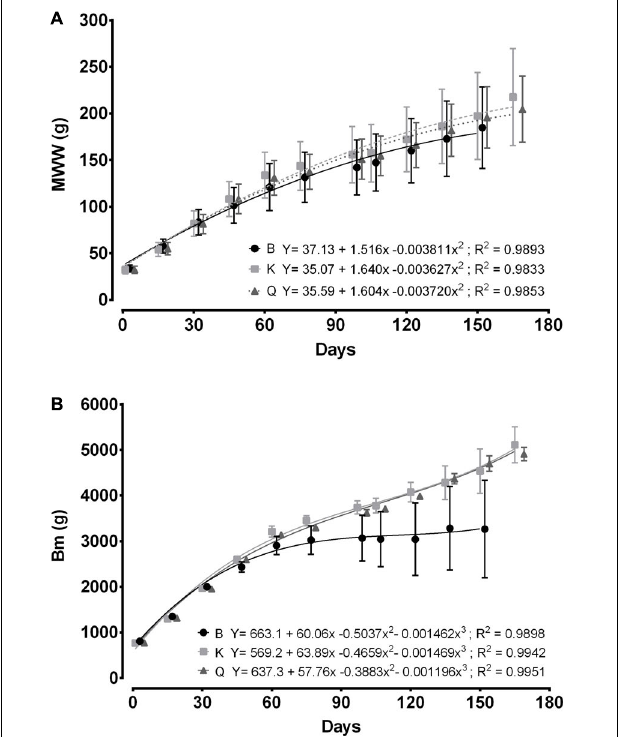
FIGURE 3 | Mean wet weight (g; A ) and biomass (g; B ) of cuttlefish breeders stocked in different tank types during the growth stage. Data are presented in offset. Bars represent standard